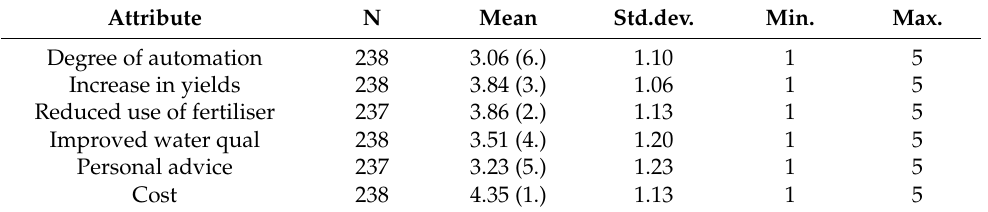
Table 5. Importance of attributes in choice tasks measured on a scale from 1 to 5 (ranking in parentheses). Attribute N Mean Std.dev. Min. Max. Degree of automation 238 3.06 (6.) 1.10 1 5 Increase in yields 238 3.84 (3.) 1.06 1 5 Reduced use of fertiliser 237 3.86 (2.) 1.13 1 5 Improved water qual 238 3.51 (4.) 1.20 Personal advice 237 3.23 (5.) 1.23 Cost 238 4.35 (1.) 1.13